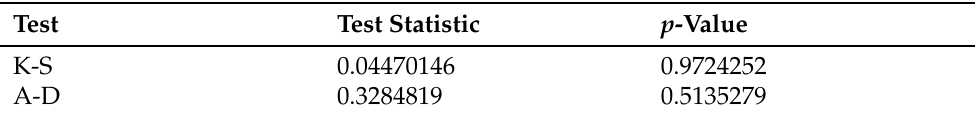
Table 10. Goodness-of-fit for KwaZulu-Natal